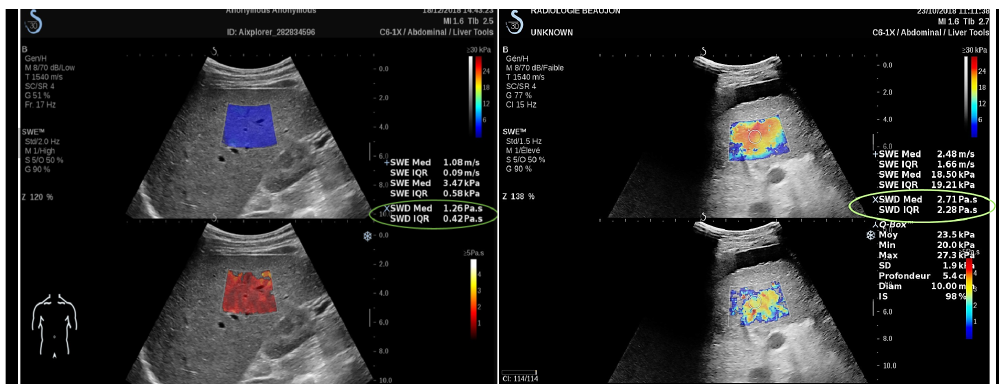
Figure 5. Measuring real-time viscosity of a volunteer patient using supersonic imagine (SSI) AIXPLORER MACH30 R (cid:13) .